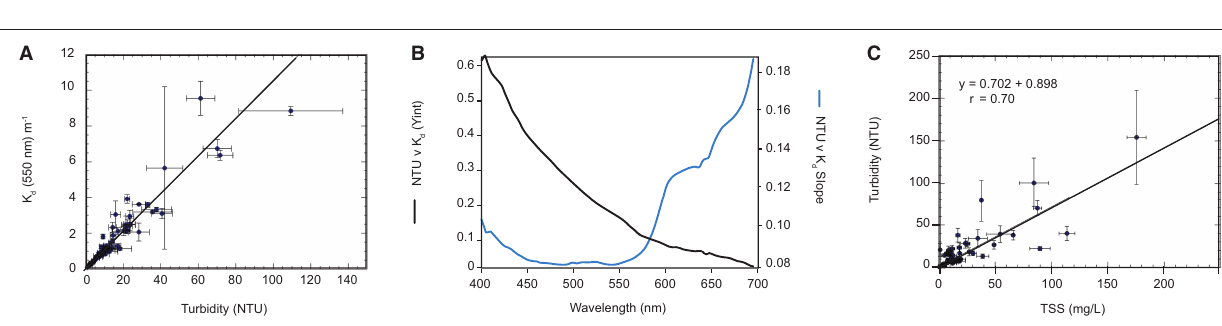
Frontiers in Marine Science |